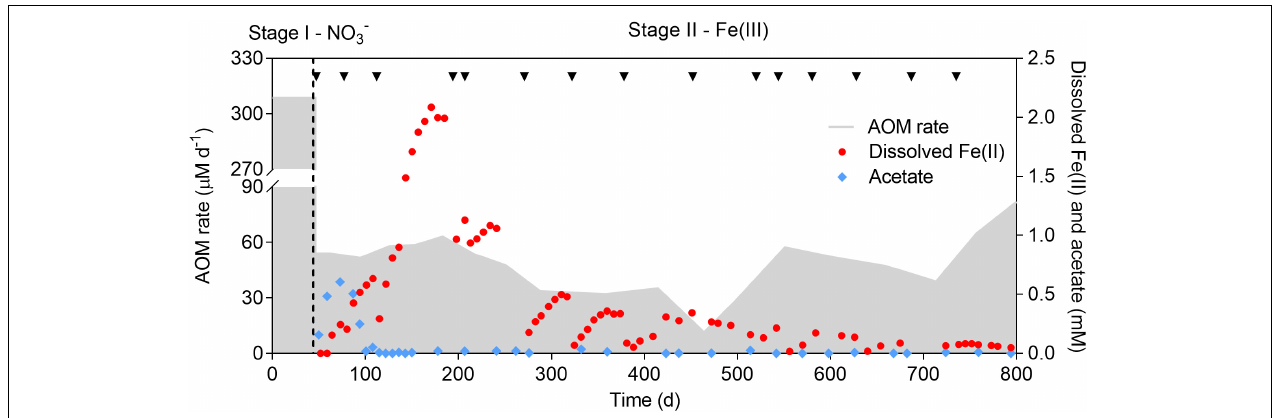
FIGURE 2 | Profiles of AOM rate, dissolved Fe(II), and acetate concentration over a period of 800 days. The incubation period was divided into two stages (indicated by the dashed line). Nitrate and ferrihydrite were supplied as the electron acceptors in Stage I and II, respectively. Black arrows show the addition of ferrihydrite. The sharp drops of dissolved Fe(II) were due to abiotic adsorption by ferrihydrite. Medium ( ∼ 10%) was replaced eevery 3 months in Stage II.